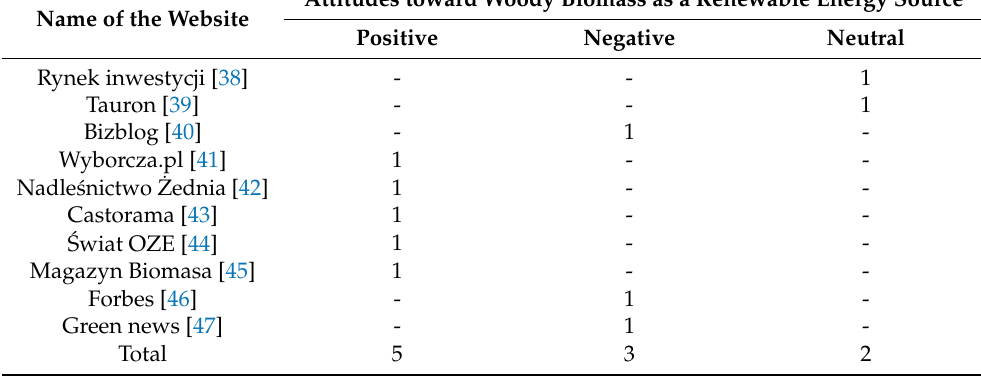
Table 1. Information and science websites (A) searched by the search term “woody biomass”